Question: Looking at the figure, what chart type is it?
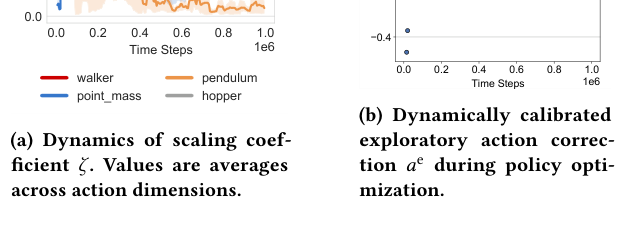
Answer: line